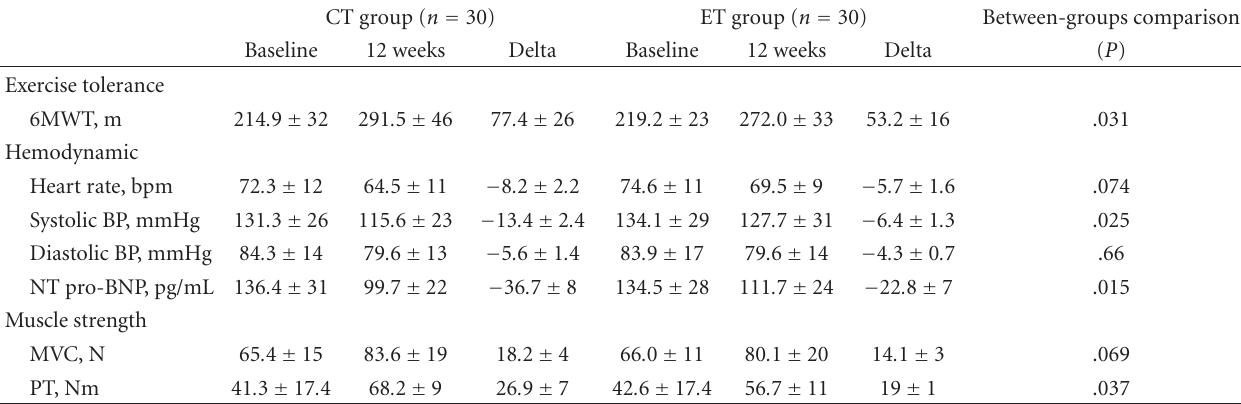
Table 2: Comparison of Delta (Baseline versus 12 Weeks) of Hemodynamic, and Muscle Strength in the CT and ET Groups. Data Are Expressed as Mean ± Standard Deviation. CT group ( n = 30) ET group ( n = 30) Between-groups comparison